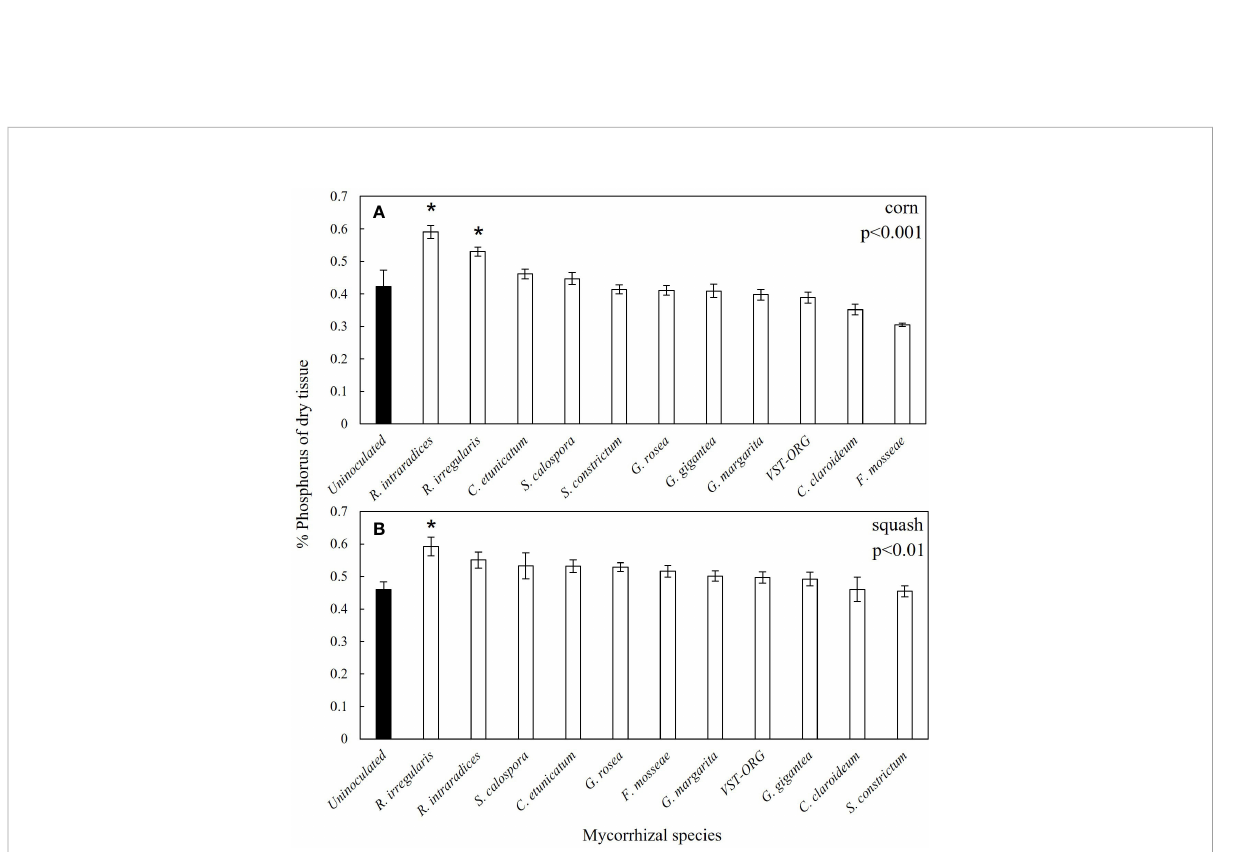
FIGURE 4 Both Rhizophagus species enhanced P uptake in corn and R. irregularis enhanced P uptake in squash. Values are mean % aboveground tissue phosphorus (n=5) presented with standard error in corn (A) and squash (B) . The closed are uninoculated seedlings and the open bars are inoculated seedlings. P values are from Kruskall-Wallace H test. Asterisks represent signi fi cant differences between uninoculated seedlings and inoculated seedlings p<0.05. Dagger represents signi fi cant differences between uninoculated seedlings and inoculated seedlings p<0.10.